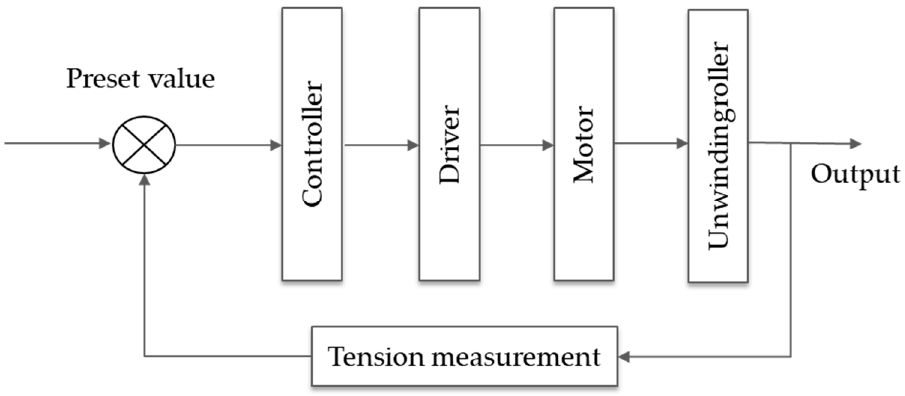
Figure 1. Control system of the tensioning.